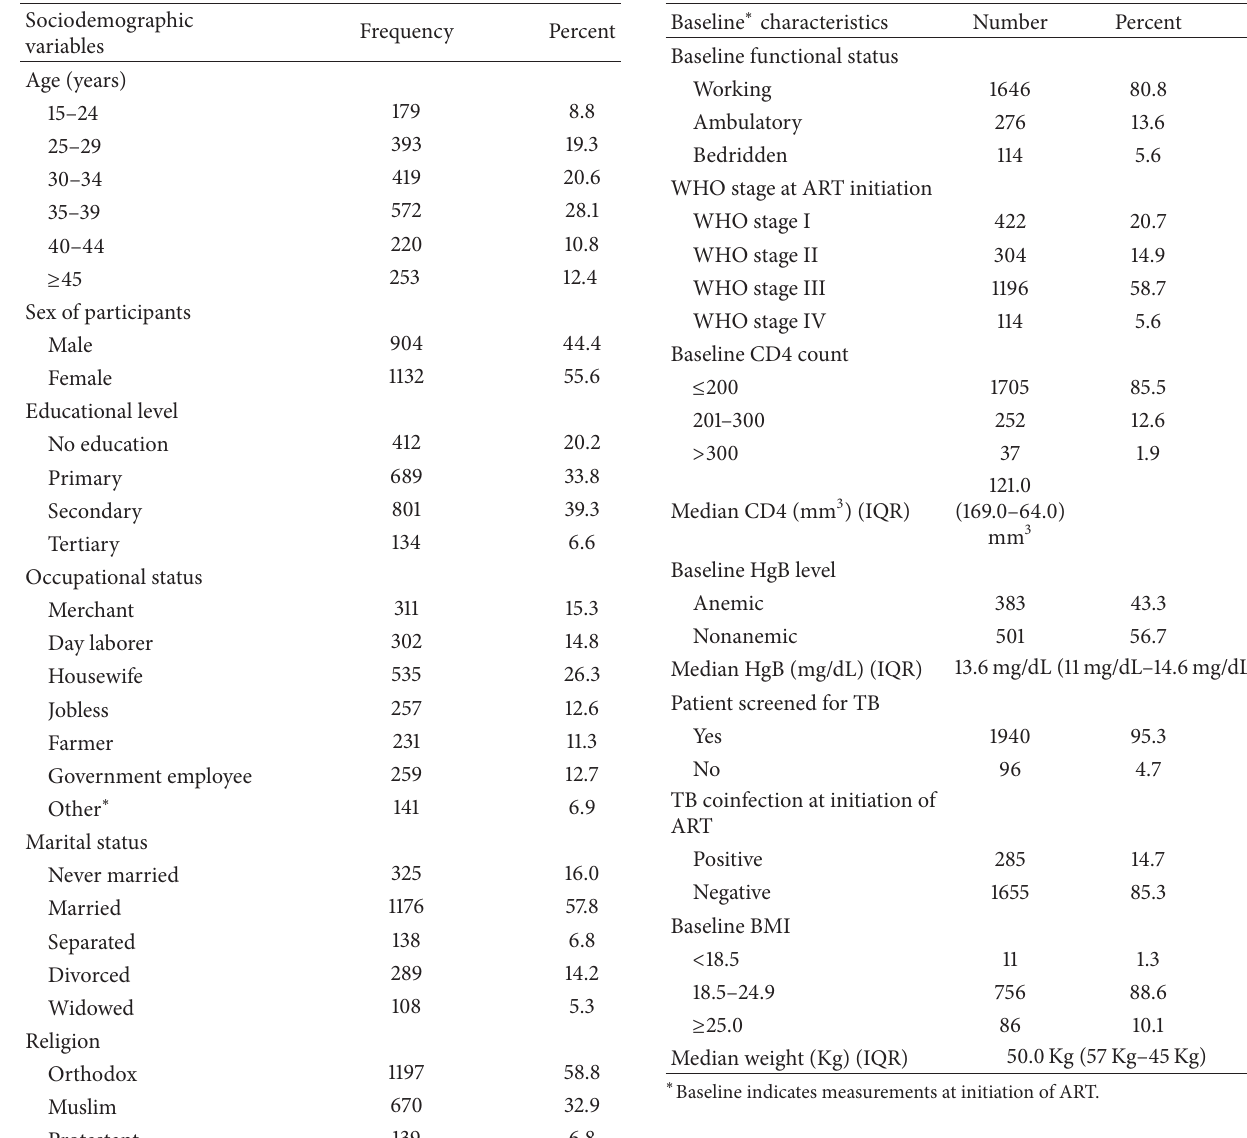
Table 1: Sociodemographic characteristics of ART clients, Goba Hospital, Southeast Ethiopia, 2013.